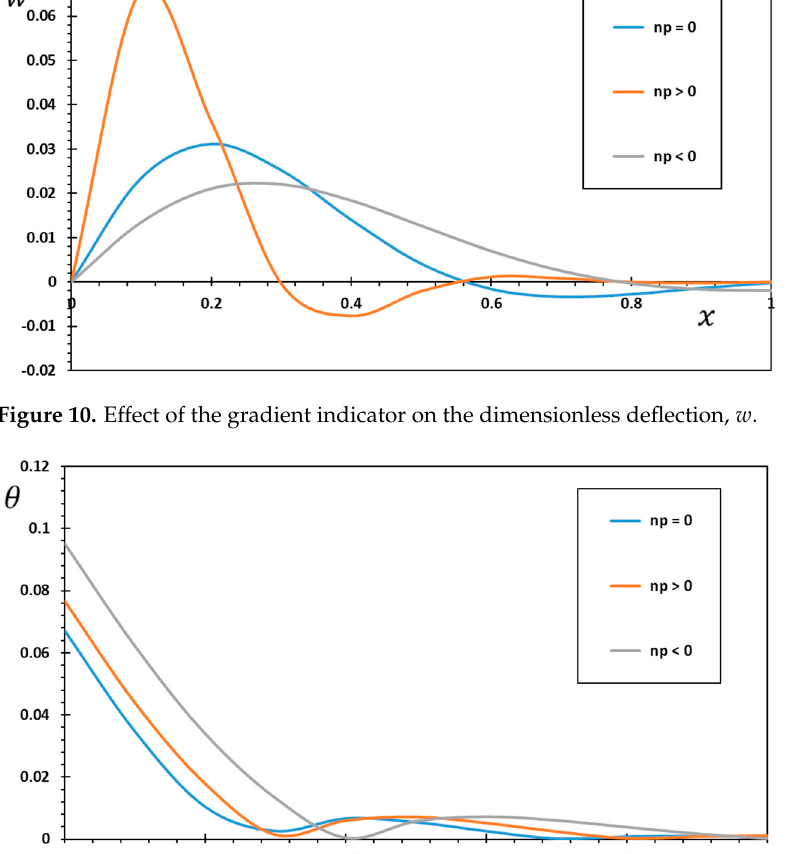
Figure 11. Effect of the gradient indicator on the dimensionless temperature, 𝜃 .